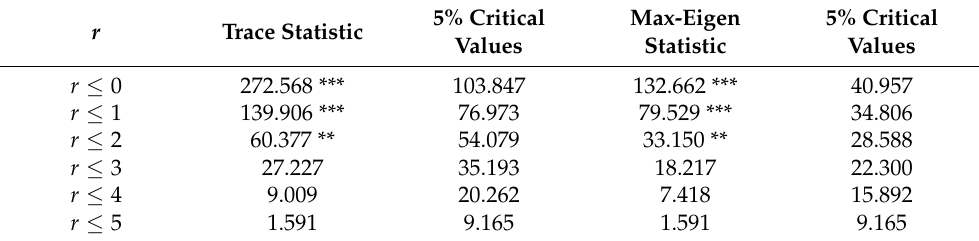
Table 3. Johansen cointegration